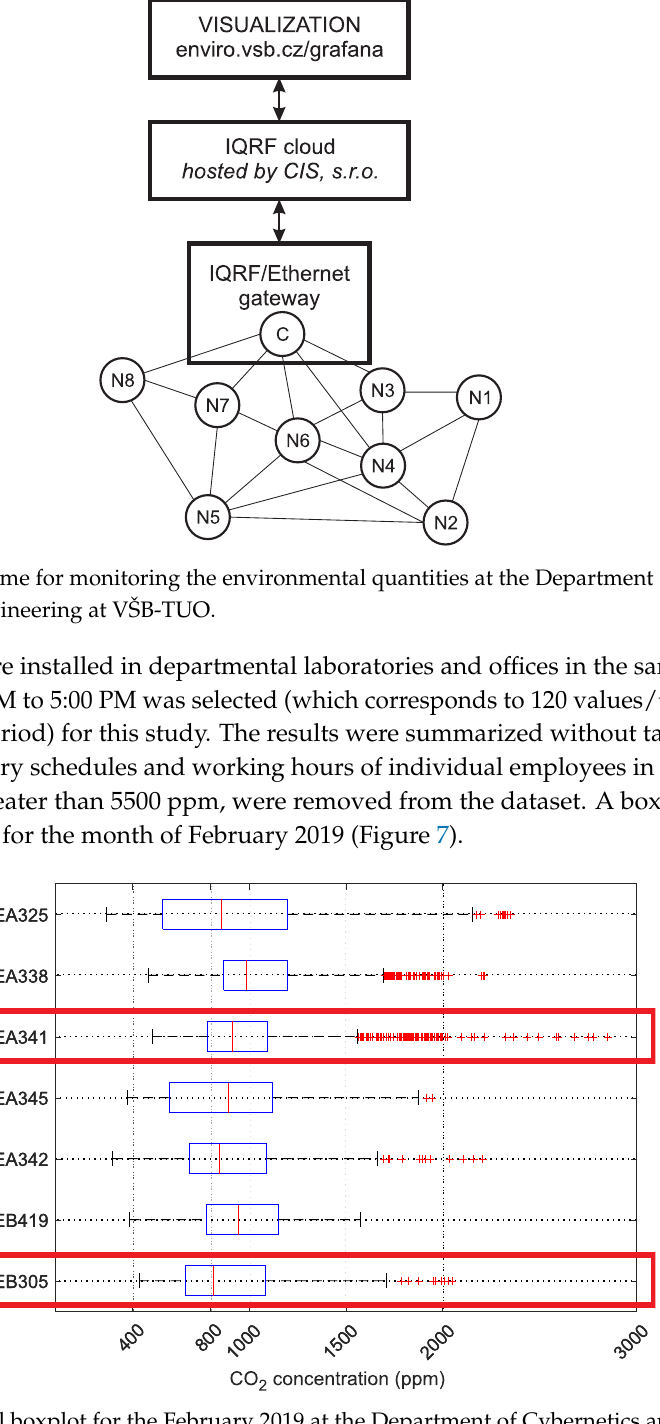
Figure 7. Horizontal boxplot for the February 2019 at the Department of Cybernetics and Biomedical Engineering, VŠB-TUO; The red boxes mean the rooms that are further analyzed in this case